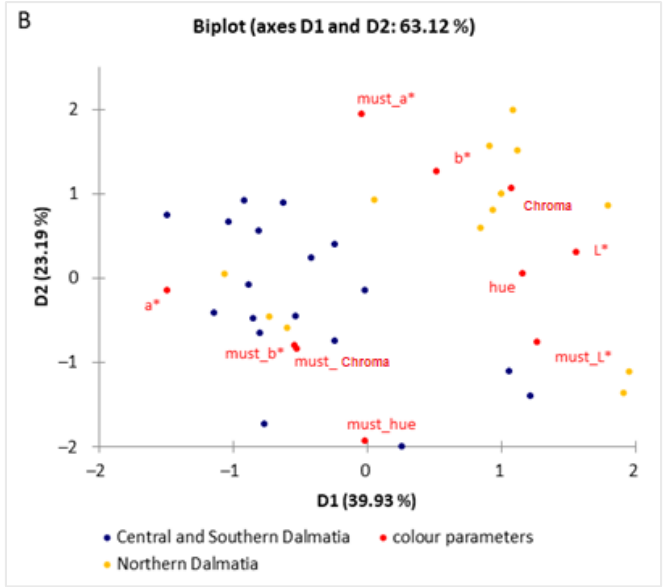
Figure 4. Qualitative observation by use of principal component analysis of must and wine physicochemical data ( A ) and colour parameters ( B ) produced from grapes of the Maraština variety grown in 10 different vineyards in two Dalmatian subregions.